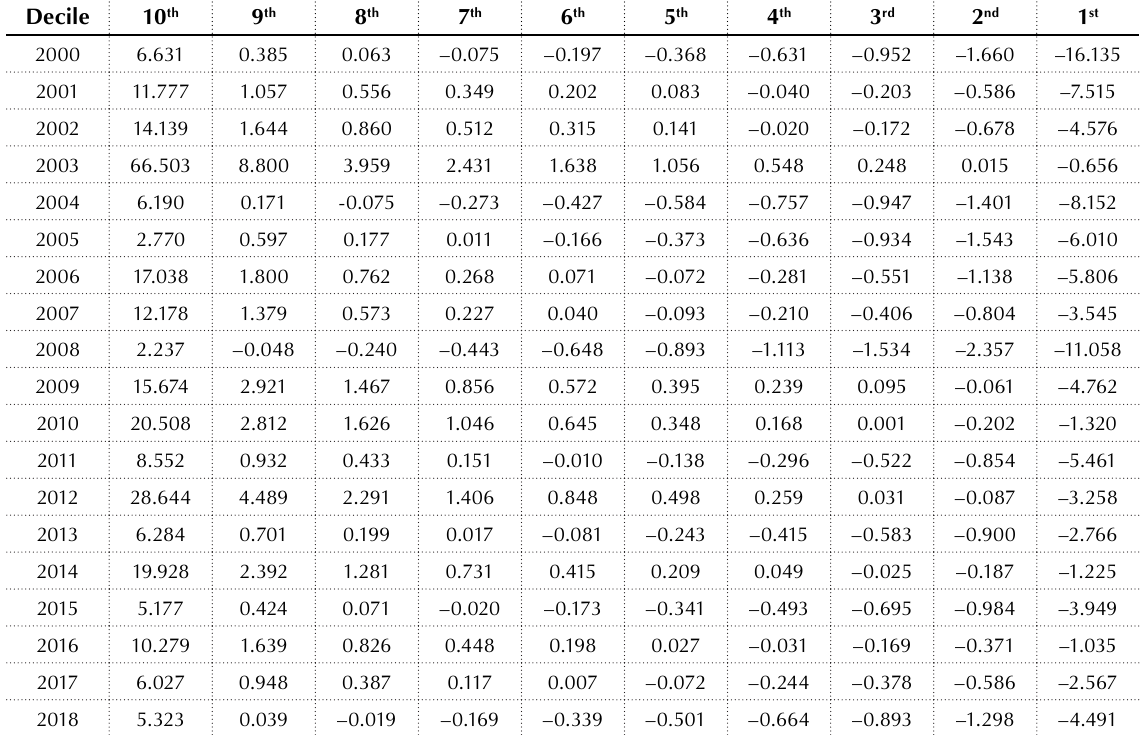
Table 4. The average MVA of the MVA’s change portfolios (million Baht)